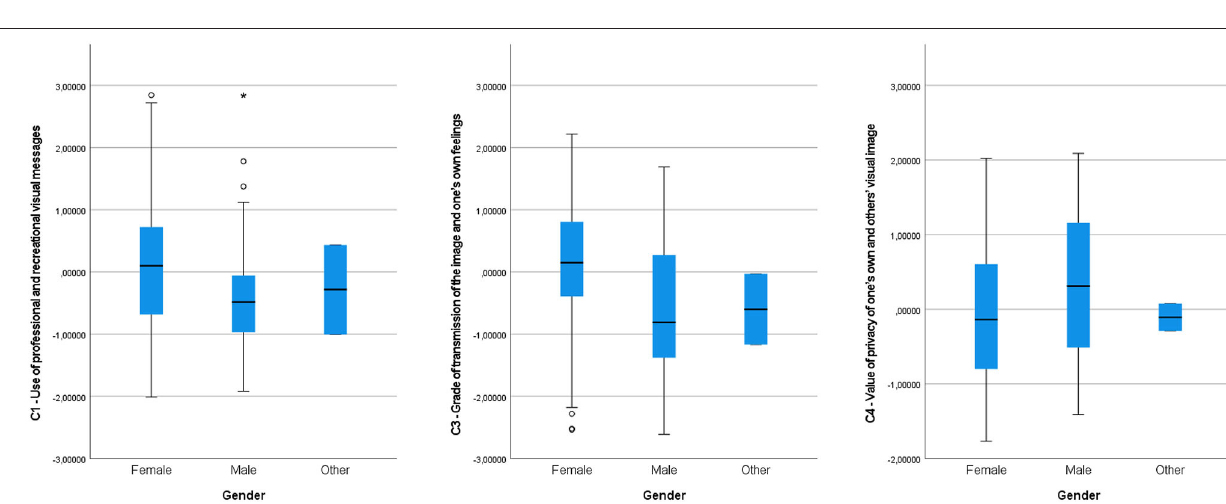
FIGURE 3 | C1, C3, and C4 comparative diagrams in the variable category